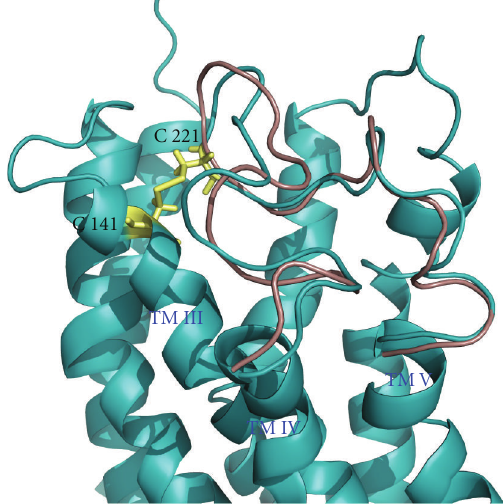
Figure 3: Superposition of two snapshots of the NMS POPC MD trajectory with NMS bound at the orthosteric binding site of the M3 receptor. In blue a snapshot before 20 ns and in pink after 20ns.